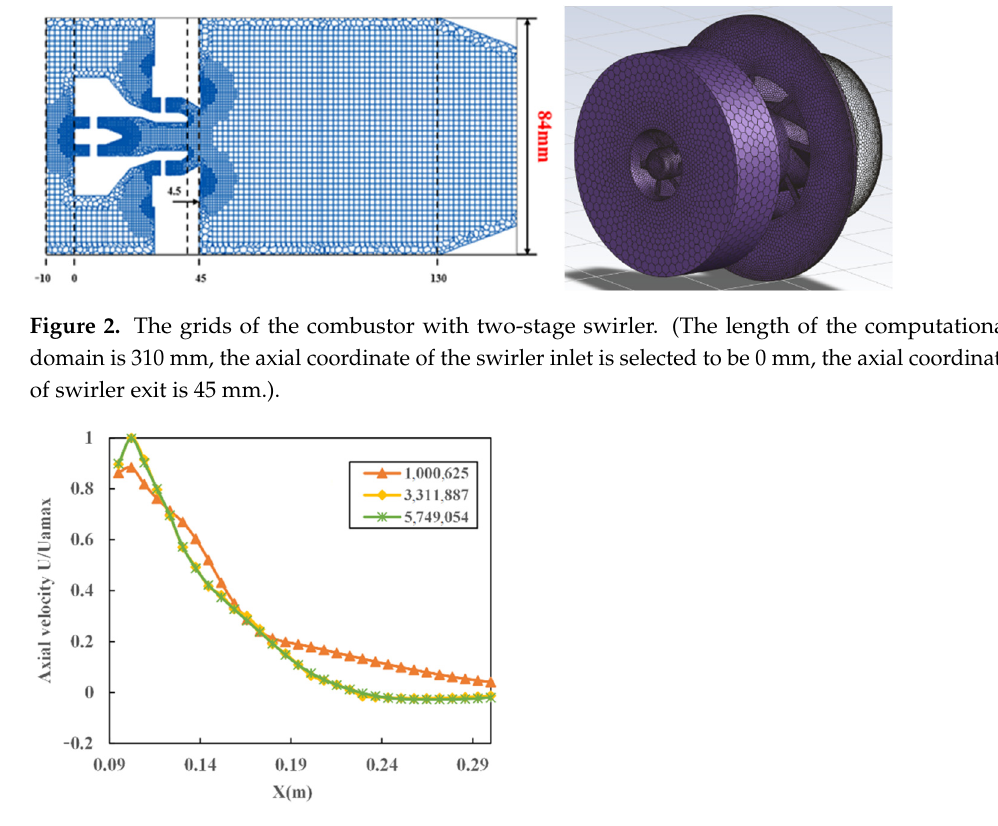
Figure 3. Axial velocity on central axis in cases of different grid numbers.